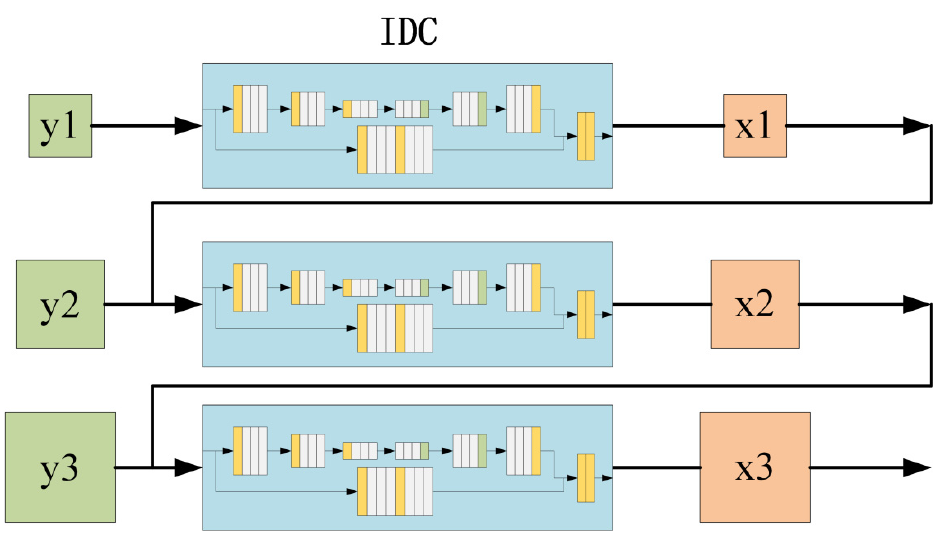
Figure 4. Multi-scale iterative